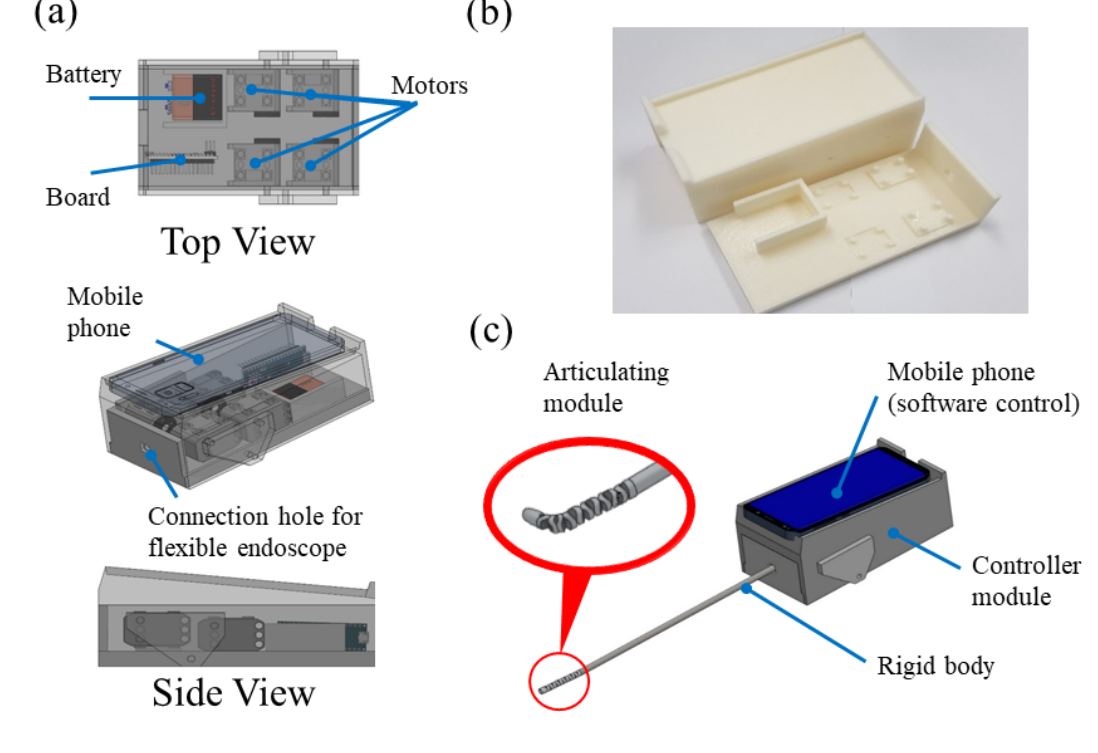
Figure 6. Controller box: (a) configuration of the components in the controller box, (b) 3D printed case of the controller box (base of case immobilizes the motors, and top lid serves as mount for the smartphone), and (c) overall outer blueprint of assembled case and magnified image of the articulating module.